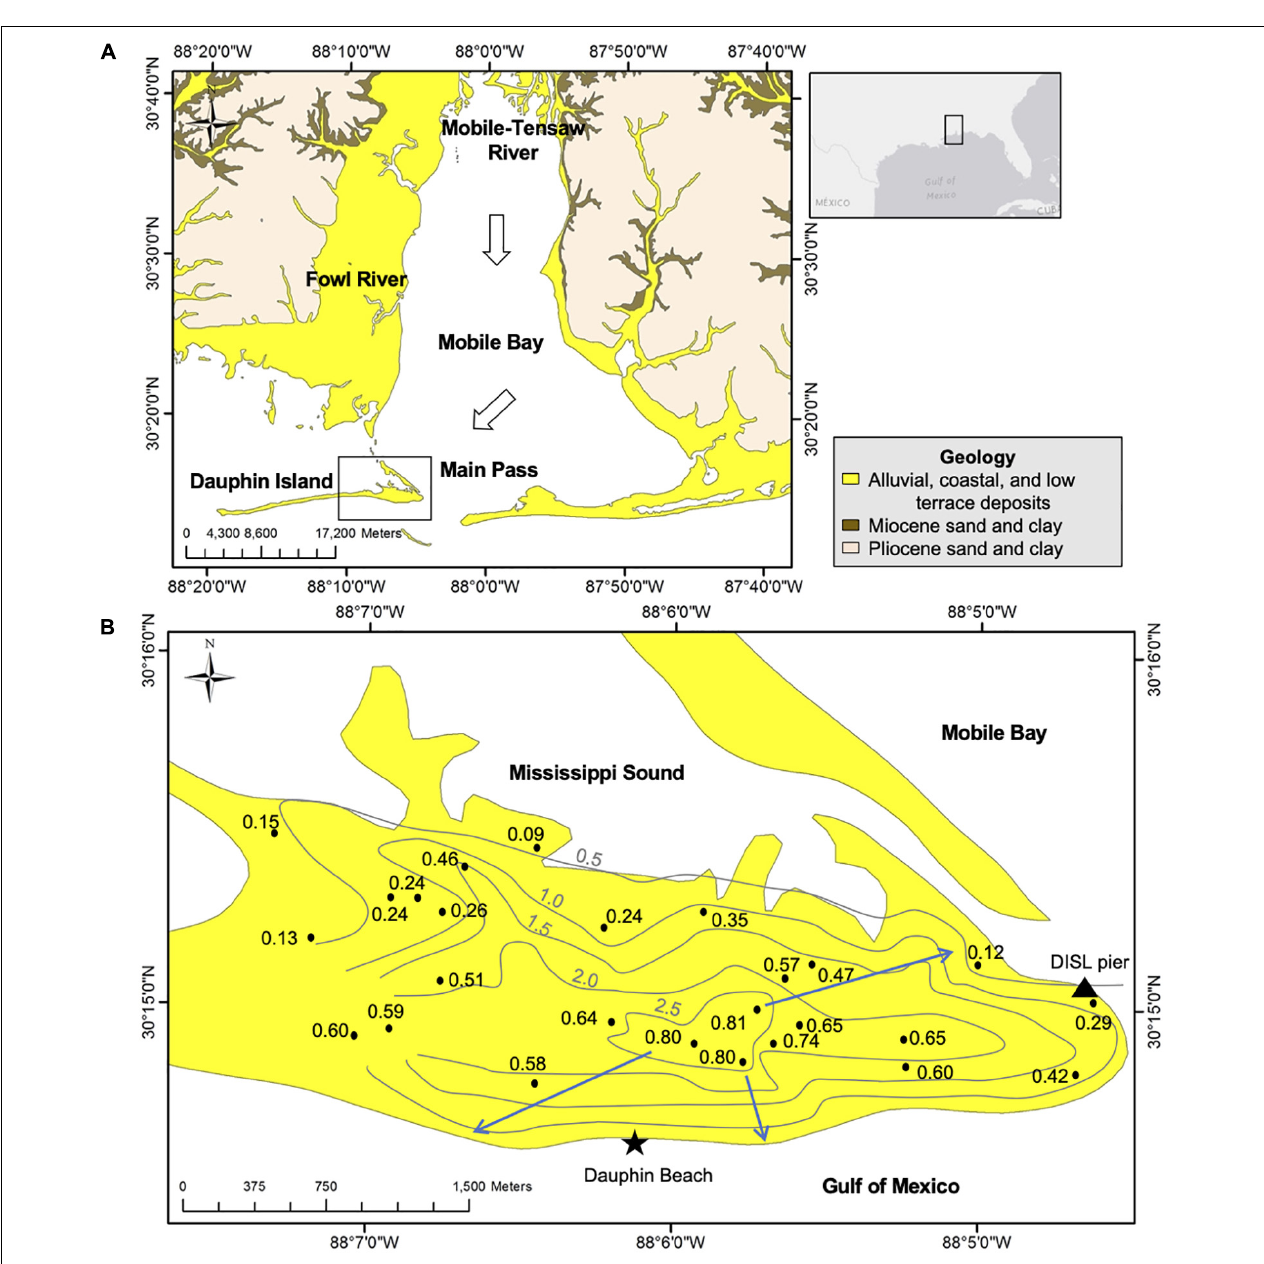
FIGURE 1 | Dauphin Island is a barrier island located in the northeastern Gulf of Mexico. The arrow in Mobile Bay represents the direction of Mobile-Tensaw River discharge (A) . 222 Rn and nutrient temporal measurements were conducted from Dauphin Island Sea Laboratory (DISL) station pier in 2014 (triangle point, B ). Groundwater sample was also collected from Dauphin Beach in 2016, next to a golf field (star point, B ). Groundwater water table altitude and contour line (in meters) is modified from Kidd (1988). The geological map is from the Geological Survey of Alabama (2020). Groundwater flow is depicted by blue line in (B)